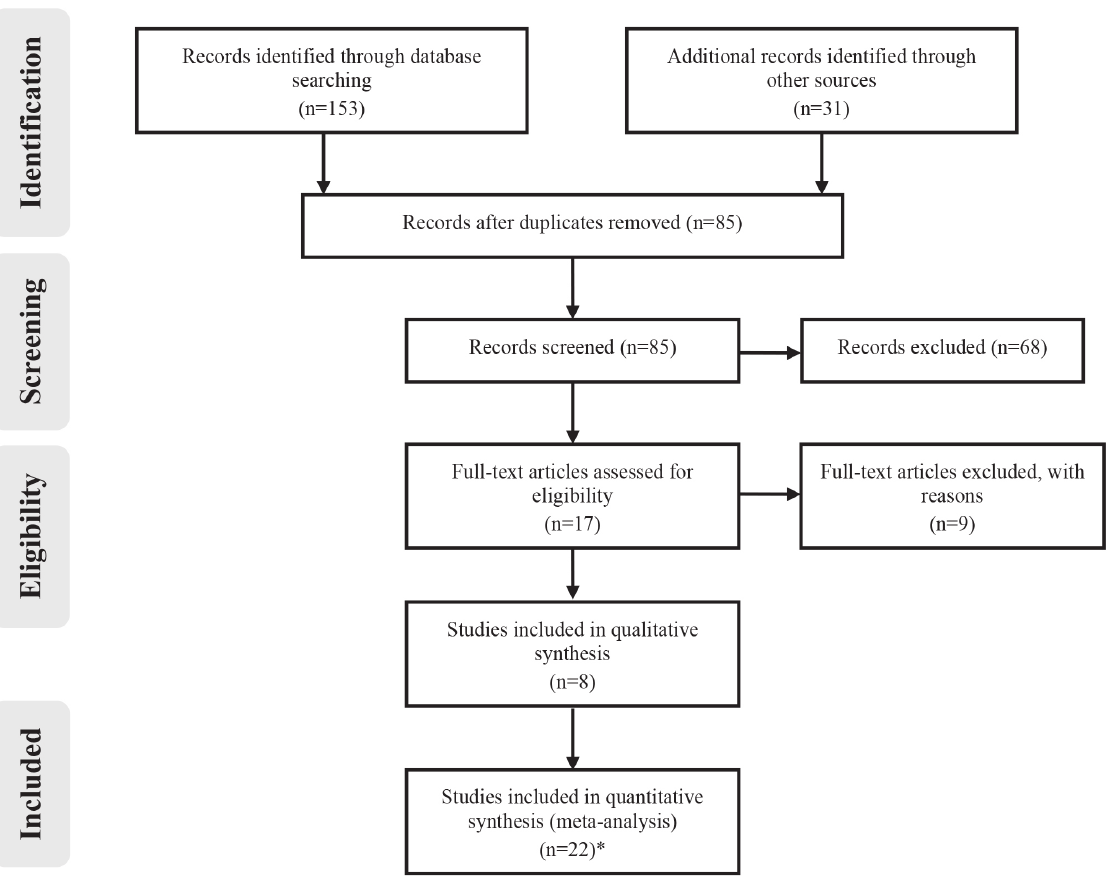
FIGURE 1 - Flow-diagram of database search, trial selection and articles included in this meta-analysis. *The works of Kim et al ., 2012 and Kim et al ., 2015 were divided into 2 different trials. The work of Klein et al ., 2011 was divided into 6 different trials. The work of Morais et al. , 2009 was divided into 8 different